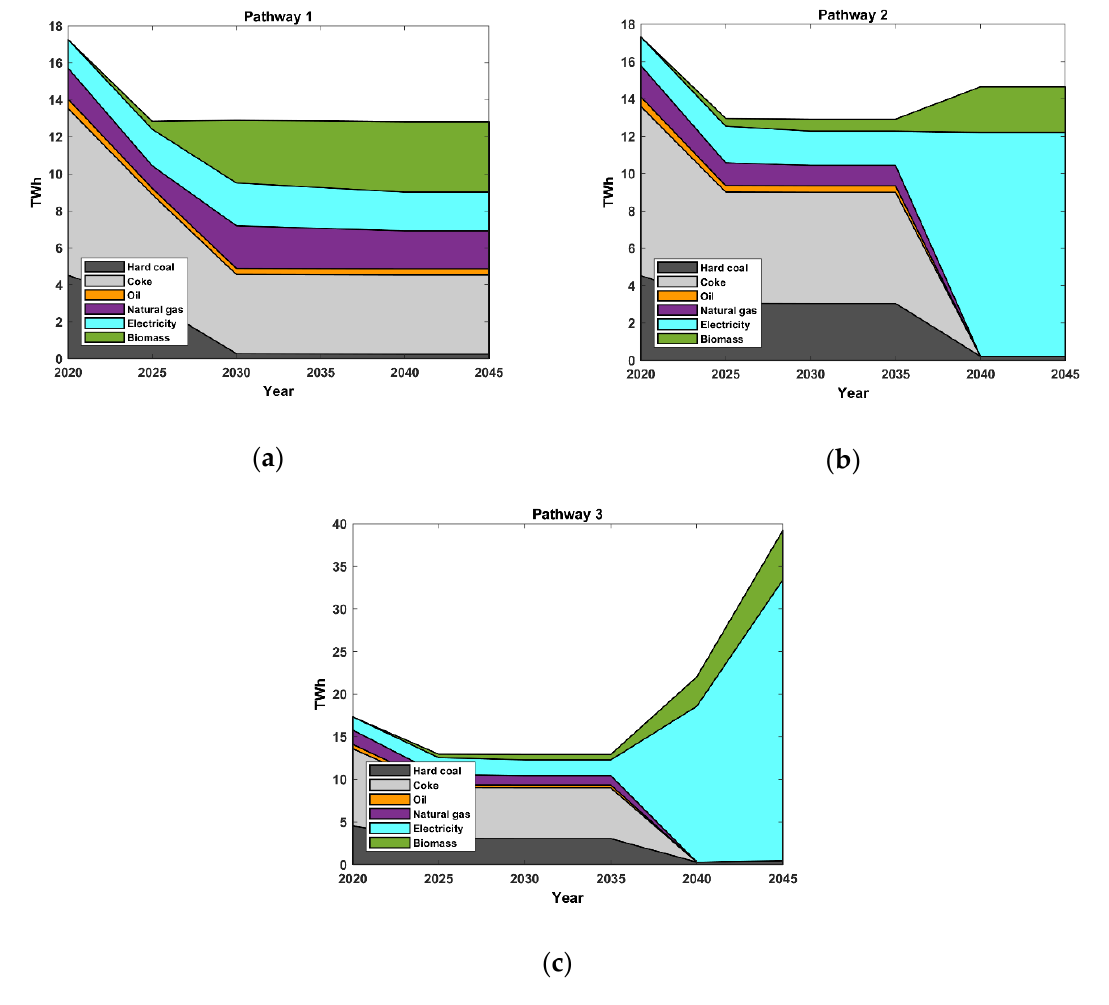
Figure 3. Energy use for the Swedish steel industry in Pathway 1 ( a ), Pathway 2 ( b ) and Pathway 3 ( c ) from 2020 to 2045. Note the different scale of the y-axis of Figure 3c.